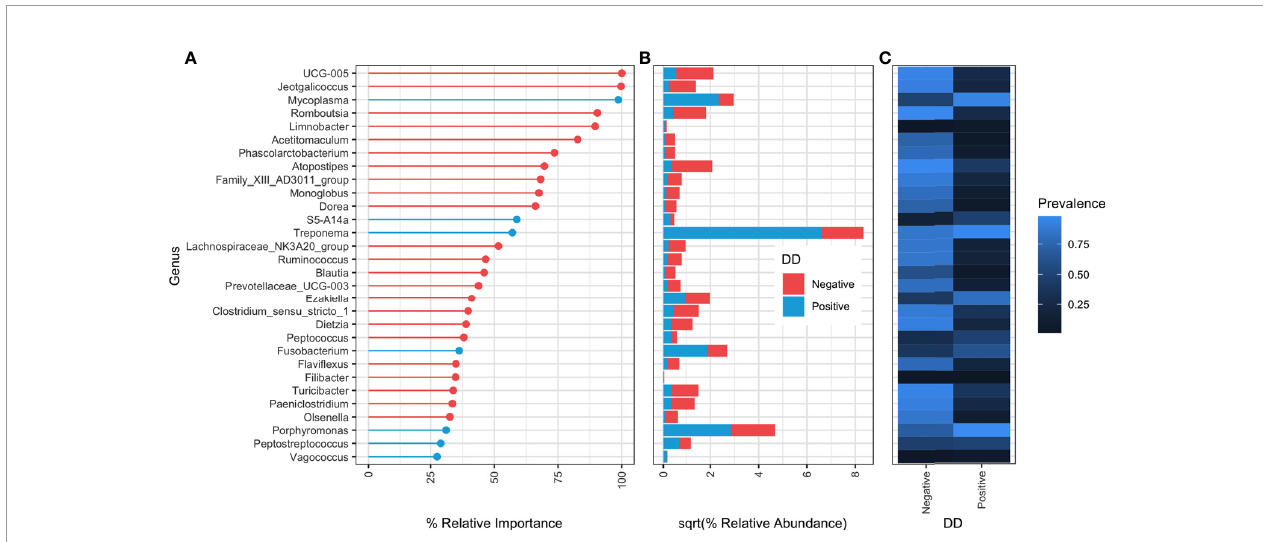
FIGURE 3 | Relative importance ranking of random forest classi fi er at genus level taxonomy. (A) Percent relative importance of top 30 genera to the random forest classi fi er. Genera are coloured red if they have higher relative abundance in DD negative skin, and blue if they have a higher relative abundance in DD positive skin. (B) Square-root transformed relative abundances in DD positive and negative skin. Relative abundances were square-root transformed for easier visualization of large differences in relative abundance between genera. (C) Proportion of samples containing at least one sequence count of each